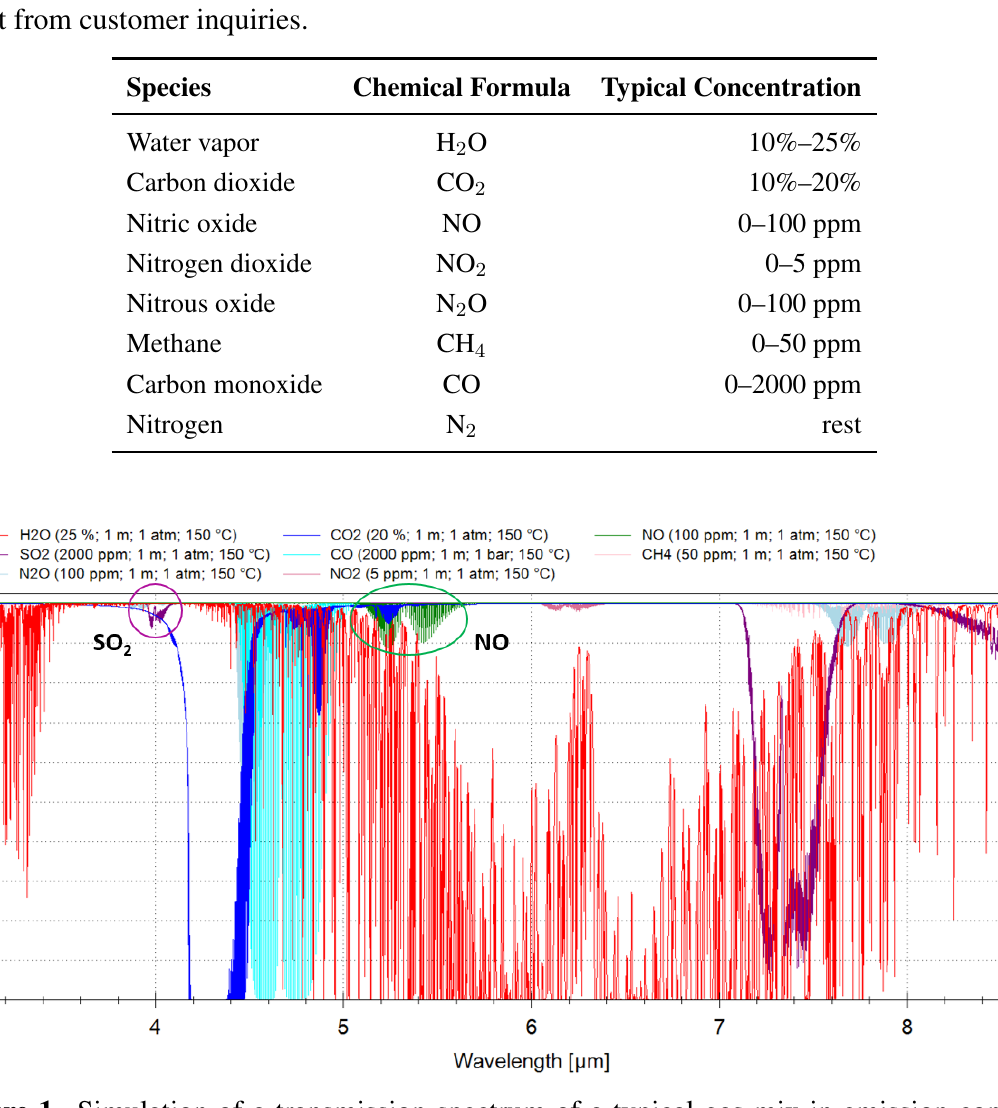
Figure 1. Simulation of a transmission spectrum of a typical gas mix in emission control using the HITRAN and HITEMP